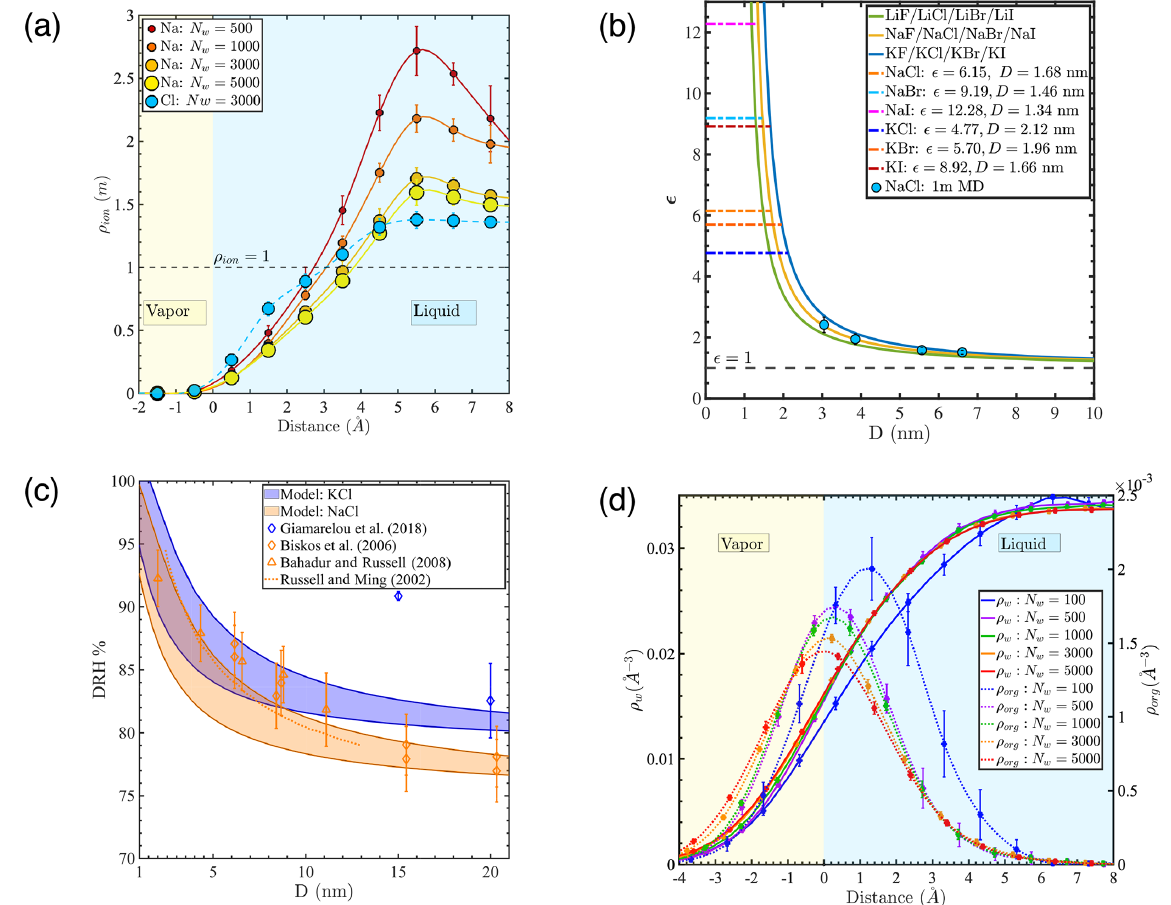
Figure 2. (a) Density profiles of Na + and Cl − ions ( ρ ion ) relative to the instantaneous interface in 1m NaCl droplets with different numbers of water molecules. (b) Salt concentration enhancement factor (cid:15) as a function of droplet diameter D for droplets with an average salinity of 1m (blue circles: MD simulation results; lines: predictions for different salts based on a simplified model, whereby the salt exclusion distance at the water–air interface equals 1.2 times the first hydration radius of the cation; horizontal dashed lines: (cid:15) values where different salts would be expected to precipitate, based on their solubility in bulk liquid water, in a droplet with an average salinity of 1m). (c) Deliquescence relative humidity (DRH) of KCl and NaCl nanoparticles as a function of diameter ( D ): shaded area marks model predictions obtained in this study; blue and orange diamonds are previous experimental results for KCl and NaCl (Biskos et al., 2006a; Giamarelou et al., 2018); orange triangles are previous MD simulation results for NaCl (Bahadur and Russell, 2008); and the orange dashed line is the NaCl DRH prediction based on a thermodynamic model (Russell and Ming, 2002). (d) Atomic density profiles of water molecules ( ρ w ) and PML molecules ( ρ org ) relative to the Gibbs dividing surface under the time-averaged interface scheme at low organic